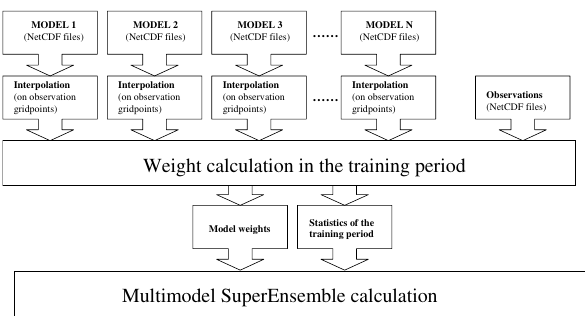
Interpolation (on observation gridpoints)